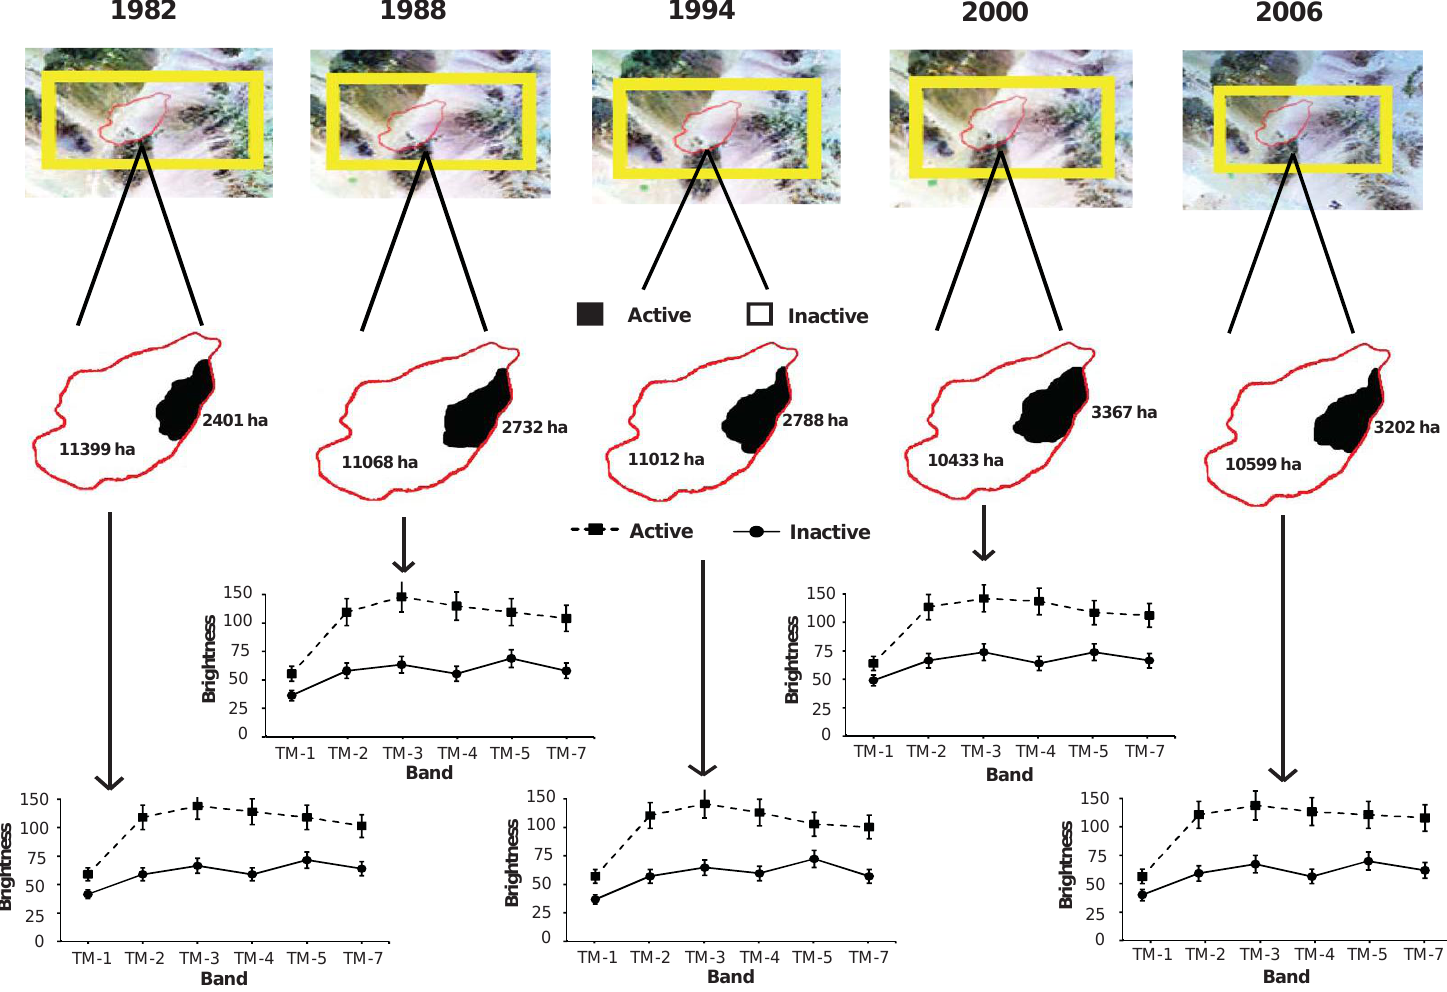
Figure 3. Flow diagram to illustrate data processing steps: mask created for Kelso Dunes in Landsat images (yellow frame), active and inactive dunes identified (in hectares), and computed brightness values. Graphs portray average, minimum, and maximum brightness values for each spectral